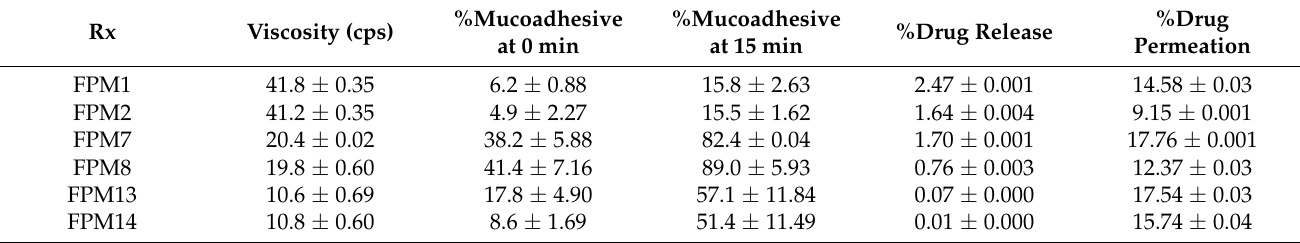
Table 2. The effects of independent variables, such as poloxamer 407 (P407), PEG400 (PEG), and sodium polyacrylate (SPA) on micelles containing 0.1% fluocinolone acetonide (FA), in relation to viscosity (cps), mucoadhesiveness (%), drug release (%), and drug permeation (%). Mucoadhesiveness was determined by the percentage of FA interacting with mucin at 0 and 15 min. Drug release and drug permeation were measured at initial 5